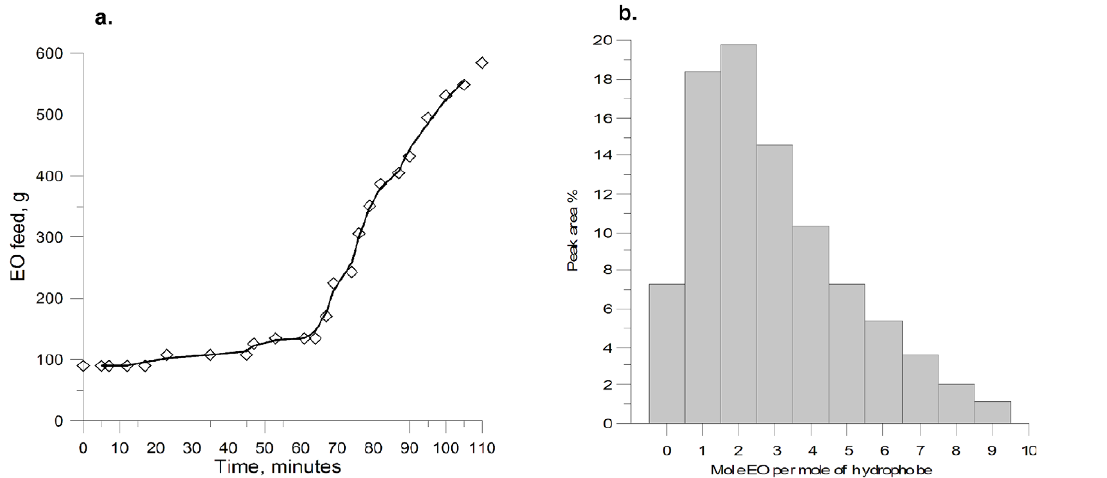
Figure 4. The EO feeding pattern (a) and homologue composition (b) of the ethoxylated C12 hydroxyester at average polyaddition degree equal to 3 (Nav.=3).